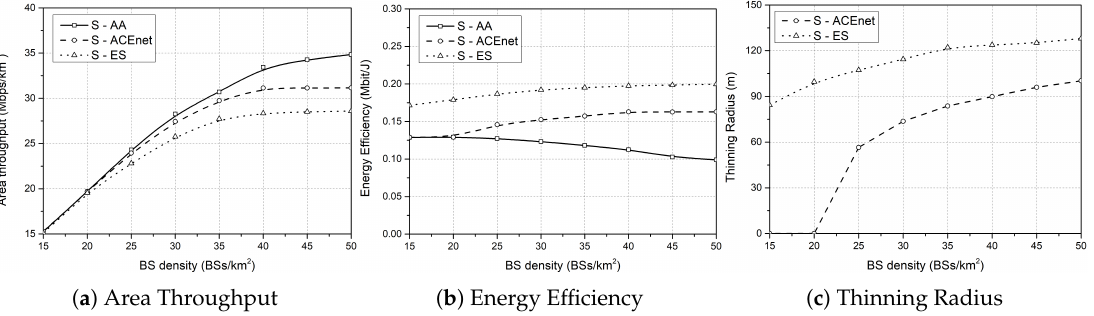
Figure 4. Area throughput, energy efficiency, and thinning radius: ACEnet vs.